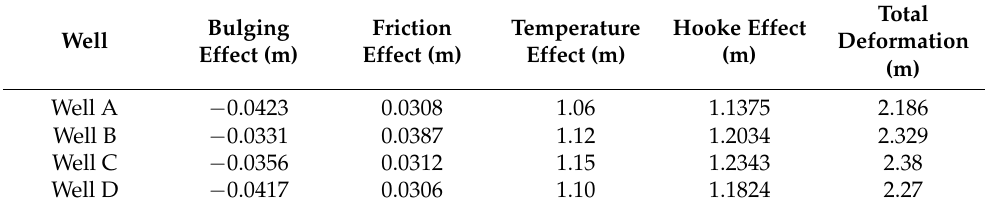
Table 4. Deformation of tubular string during CO 2 injection in four wells.